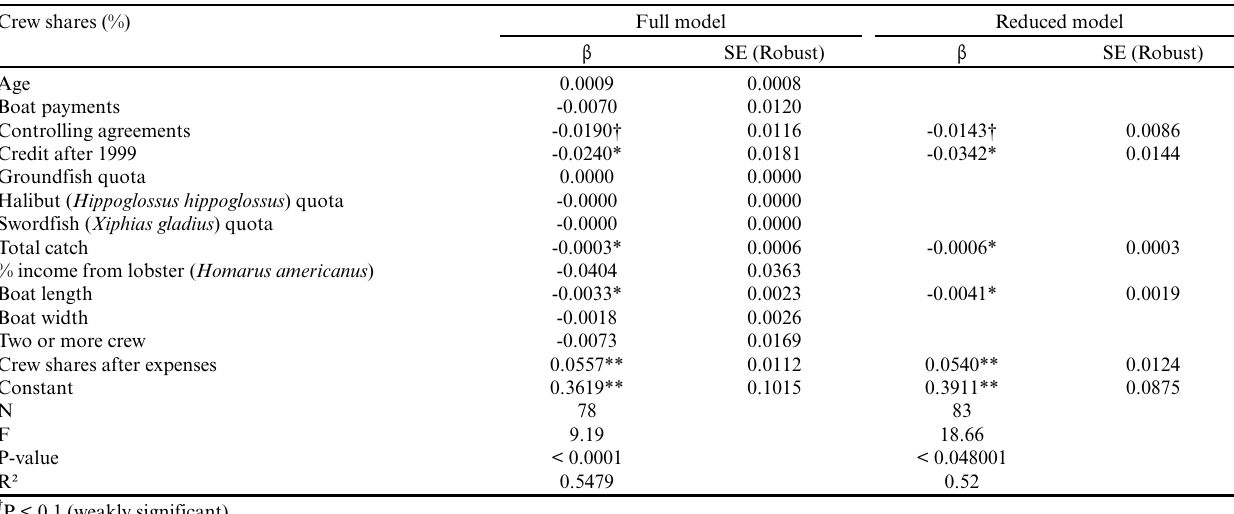
Table 4 . Linear regression of factors explaining winter